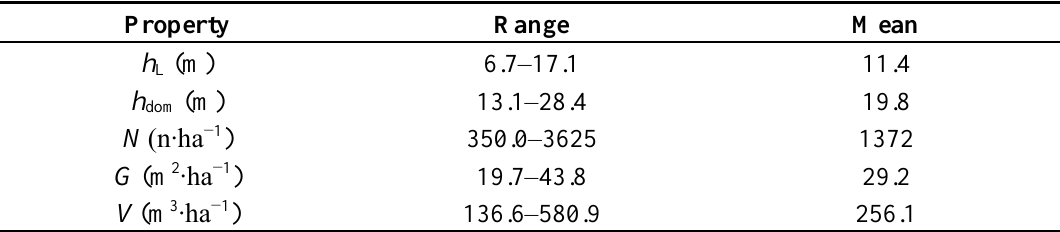
Figure 1. Project overview with field plots and ground control point locations. The flight blocks show how the imagery data were collected according to the office-planning phase. Table 1. Summary of the field data a